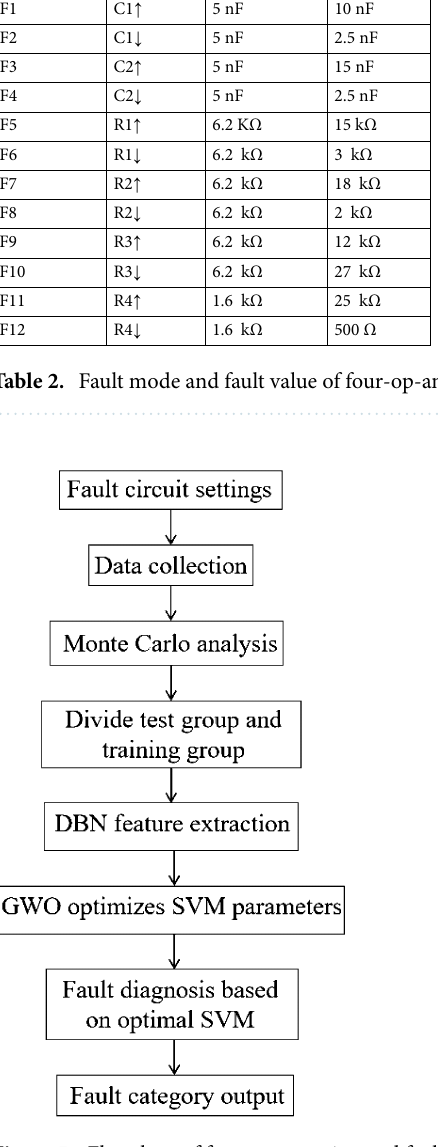
Figure 5. Flowchart of feature extraction and fault